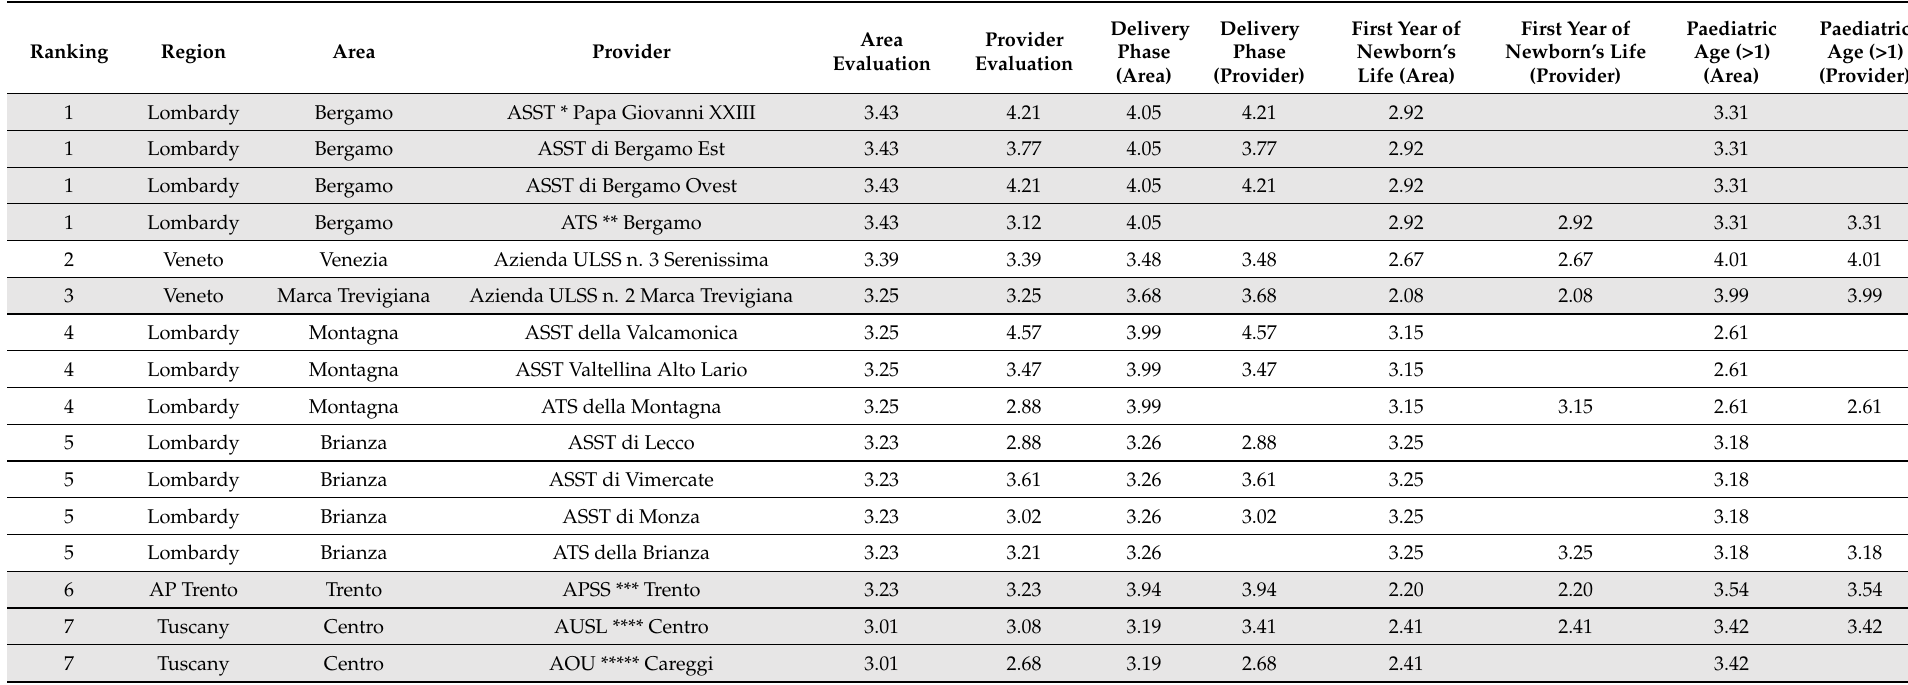
Table 2. Ranking of best performers by GA and provider extracted from the results of the quantitative